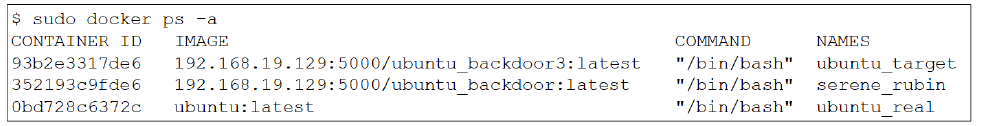
Figure 27. ubuntu_target docker container list accessed from ubuntu_attacker (1).